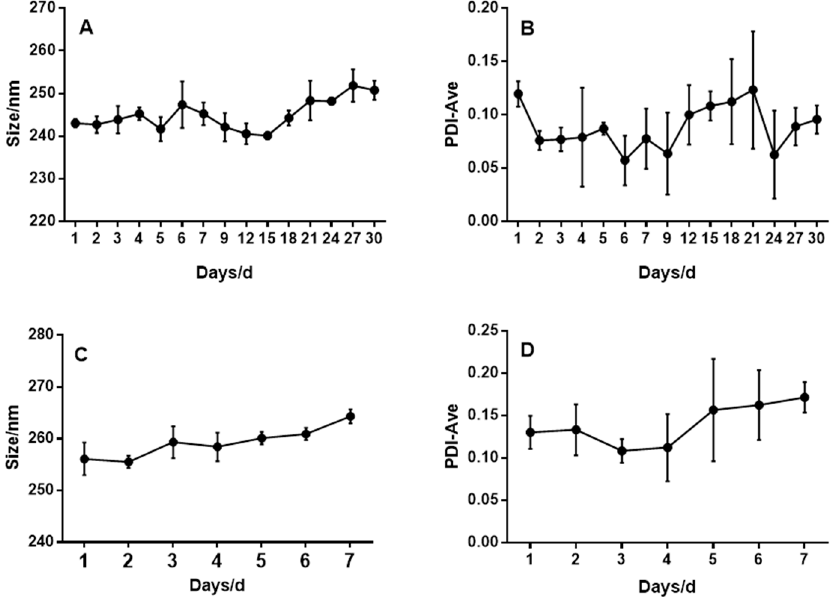
Figure 3. Stability test of BGPs and RBGPs. Size ( A ) and PDI ( B ) stability of BGPs over a span of 30 days. Size ( C ) and PDI ( D ) stability of RBGPs over a span of 7 days. All values are expressed as mean SD ( n = 3), and the test was repeated independently in triplicate.